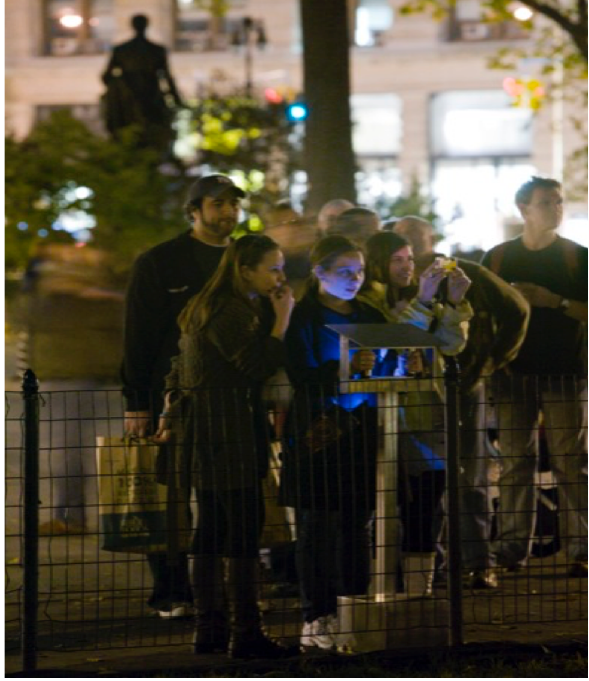
Figure 6 | Rafael Lozano-Hemmer, Pulse Park , Relational Architecture 14, 2008. Photo by James